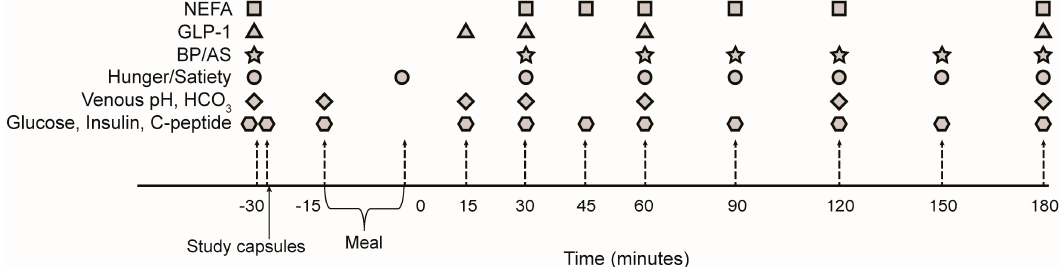
Figure 2. Overview of the meal study. The treatment was administered following collection of baseline (fasting) samples at t = − 30 min. The sodium bicarbonate or placebo capsules were administered after collecting the baseline samples/measurements. Consumption of the meal commenced 15 min after administration of the treatment at t = − 15, and participants allowed 20 min to complete the meal ( t = 0 marks completion of the meal). Time points − 15 and 15 min were only collected in n = 15 participants. Abbreviations: AS, arterial stiffness; BP, blood pressure; GLP-1, glucagon-like peptide 1; NEFA, non-esterified fatty acids. Table 1. Nutritional breakdown of the study